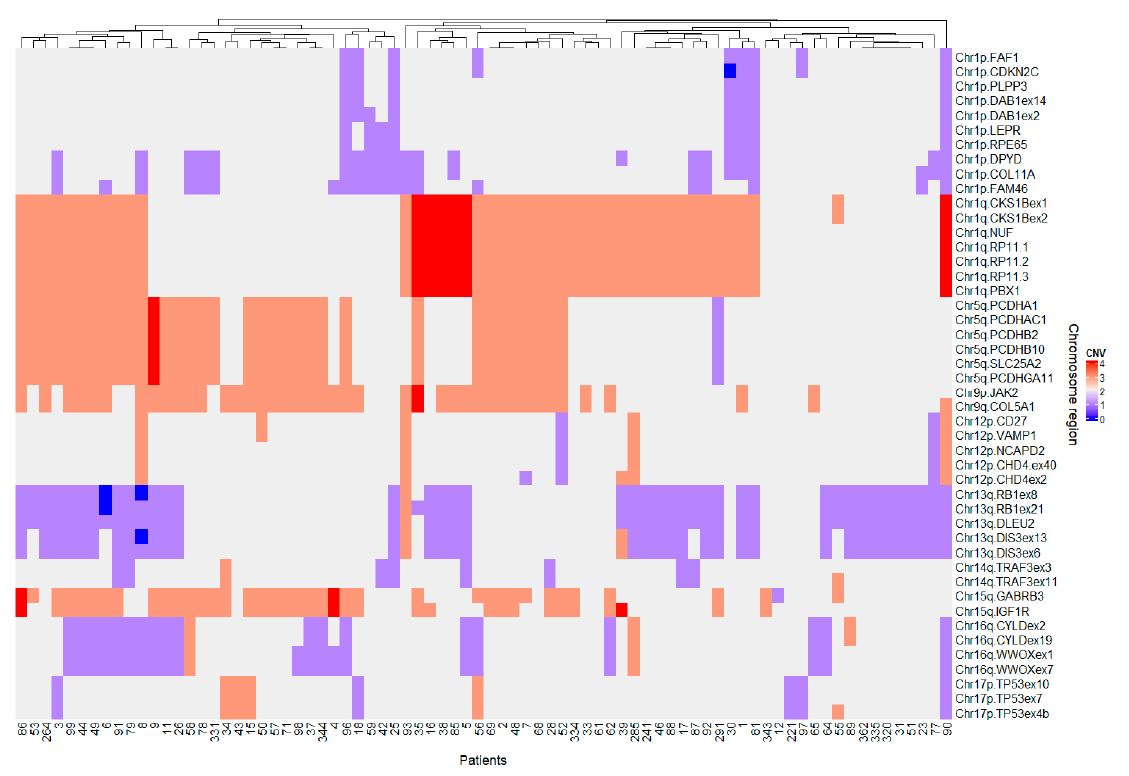
Figure A1. Heatmap of the CNA distribution (the patients who didn’t present any CNAs were excluded). 0-homozygous deletion, 1-heterozygous deletion, 2-normal, 3,4-duplications.